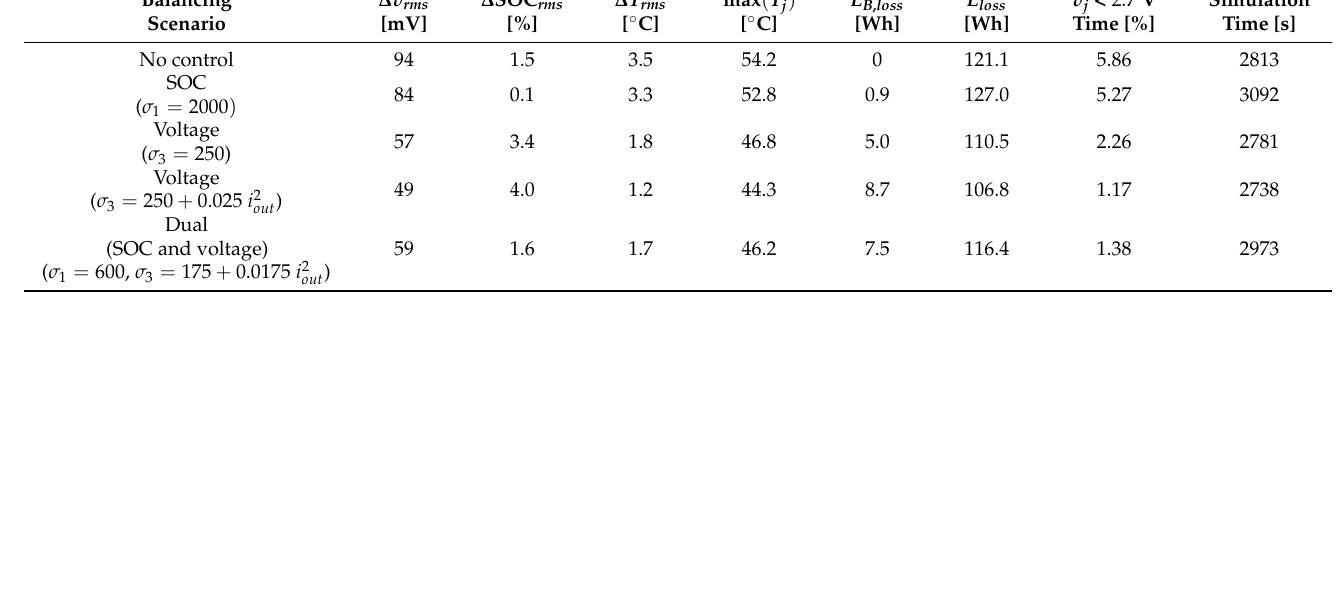
Figure 15. Single and dual controllers results in time. End condition: min (US06), mixed agingg, parallel forced air cooling ( h = 15 W/m 2 K).